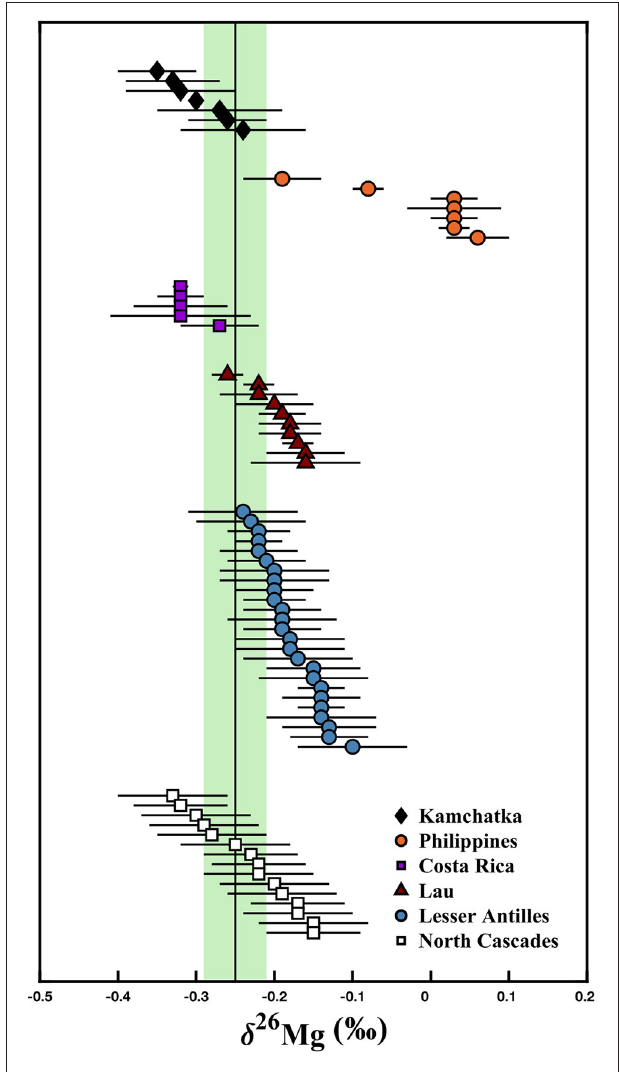
FIGURE 1 | Mg isotope composition of volcanic arc samples. Lesser Antilles data from Teng et al. (2016); Kamchatka, Philippines, Costa Rica, and Lau data from Li et al. (2017); North Cascades data from the present study. The black line and green bar represent the mantle composition based on peridotite xenoliths ( δ 26 Mg = − 0.25 ± 0.04 ‰ ) from Teng et al. (2010a). North Cascades data are reported in Table 1 . Error bars represent the 2 SD for each